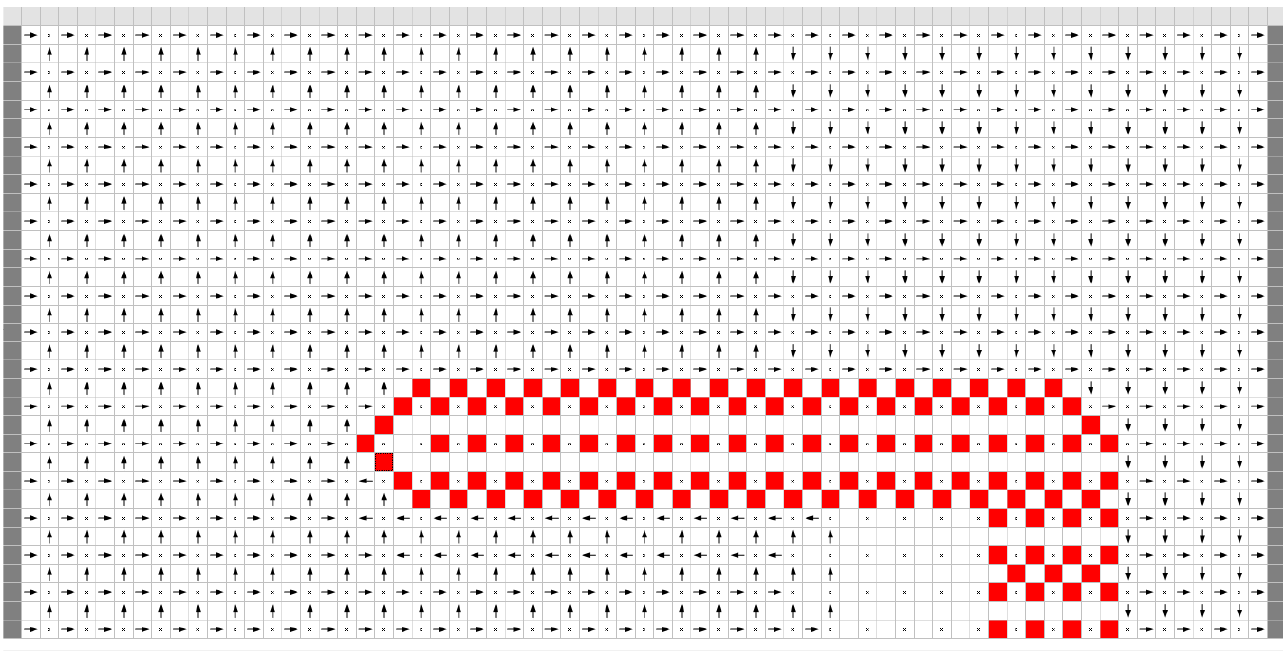
Figure 12. Current directions over the grid branches after a laser trim.